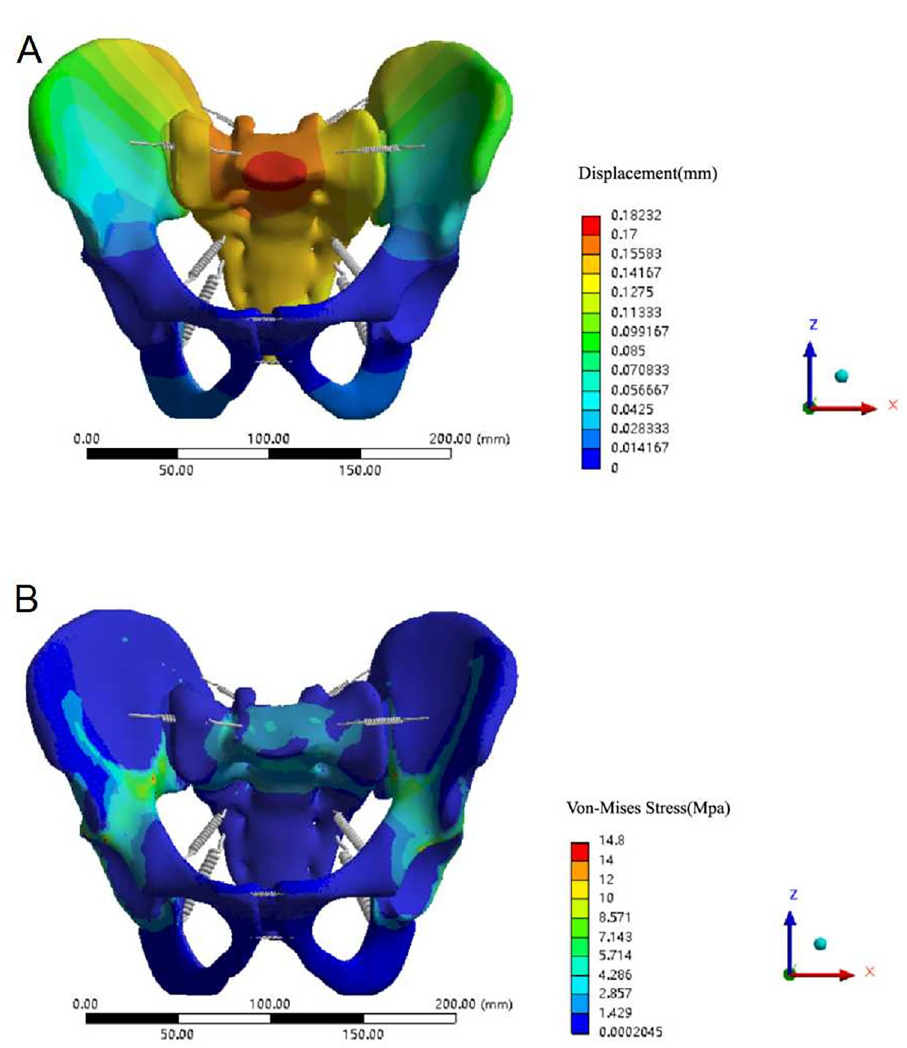
Fig 4. Displacement and Von Mises stress distribution of the normal pelvis model. (A) Displacement distribution of the normal pelvis model under a vertical load. (B) Von Mises stress distribution of the normal pelvis model under a vertical